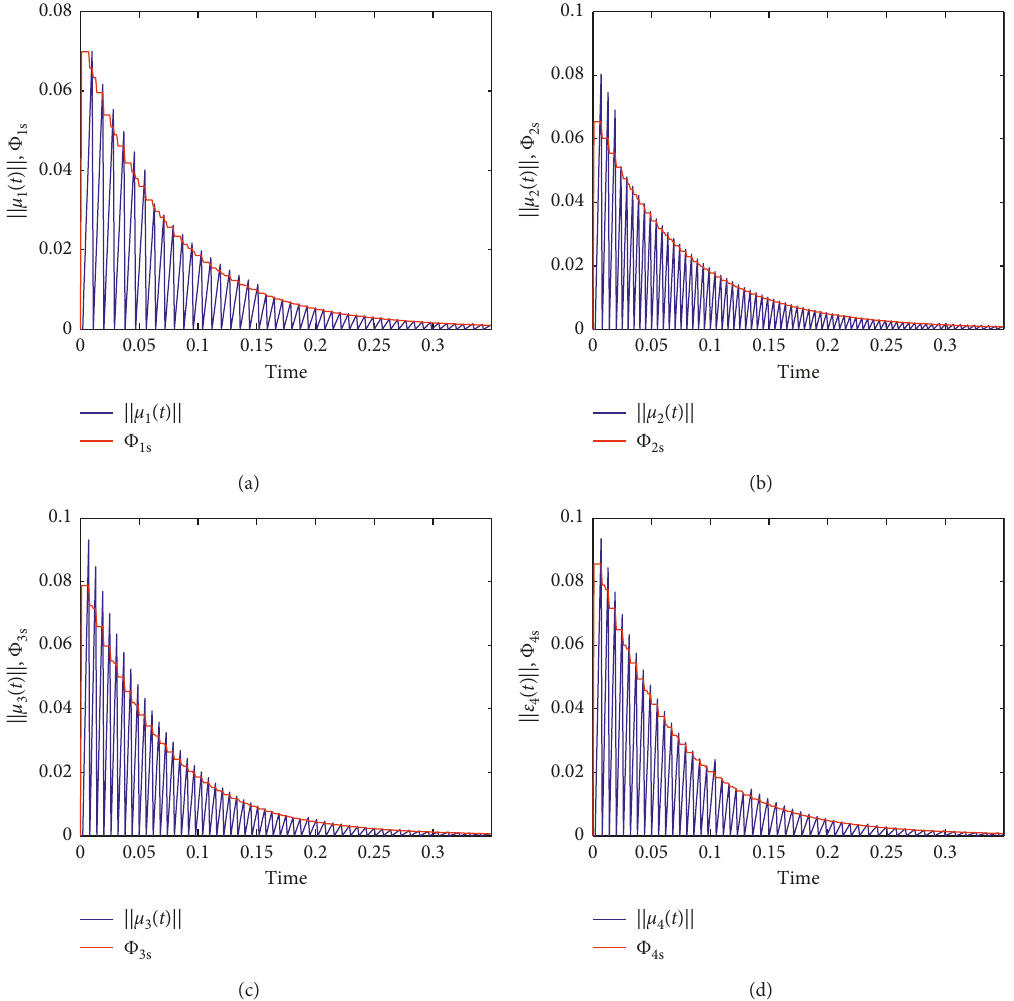
Figure 4: Time evolutions of measurement errors μ